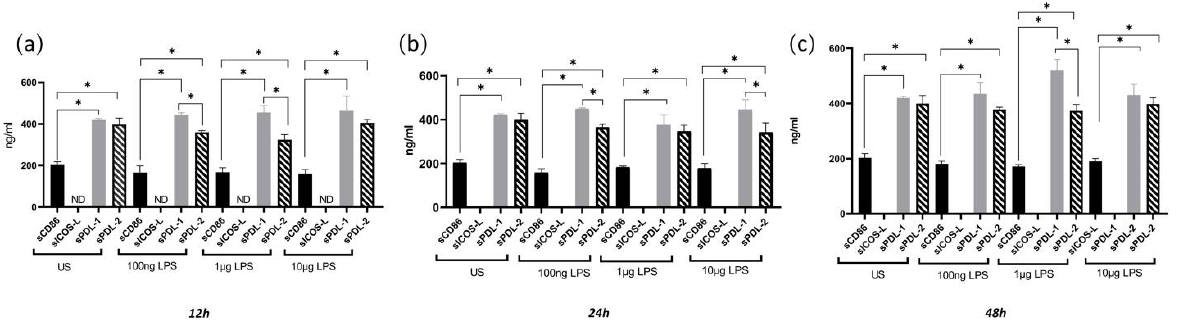
Figure 6. Concentration of soluble CD86, ICOS-L, PDL1, and PDL2 in the supernatant culture of Mo-DCs after ( a ) 12, ( b ) 24, or ( c ) 48 h of stimulation. Mo-DCs from healthy donors were stimulated for 12, 24, or 48 h with 100 ng, 1 µg, or 10 µg of LPS or were left unstimulated (US). ICOS-L was not detected in any of the conditions evaluated. The mean ± SD of soluble costimulatory molecule concentration for 3 independent assays performed in triplicate is depicted in the graphs. * p <